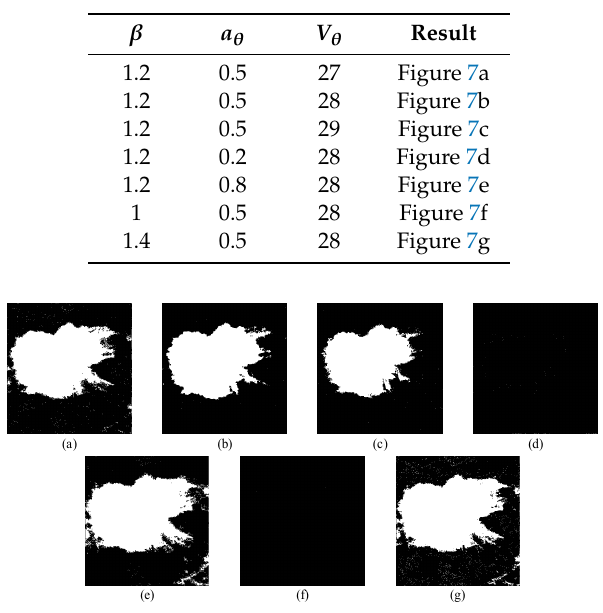
Table 3. Set the PCNN parameters.